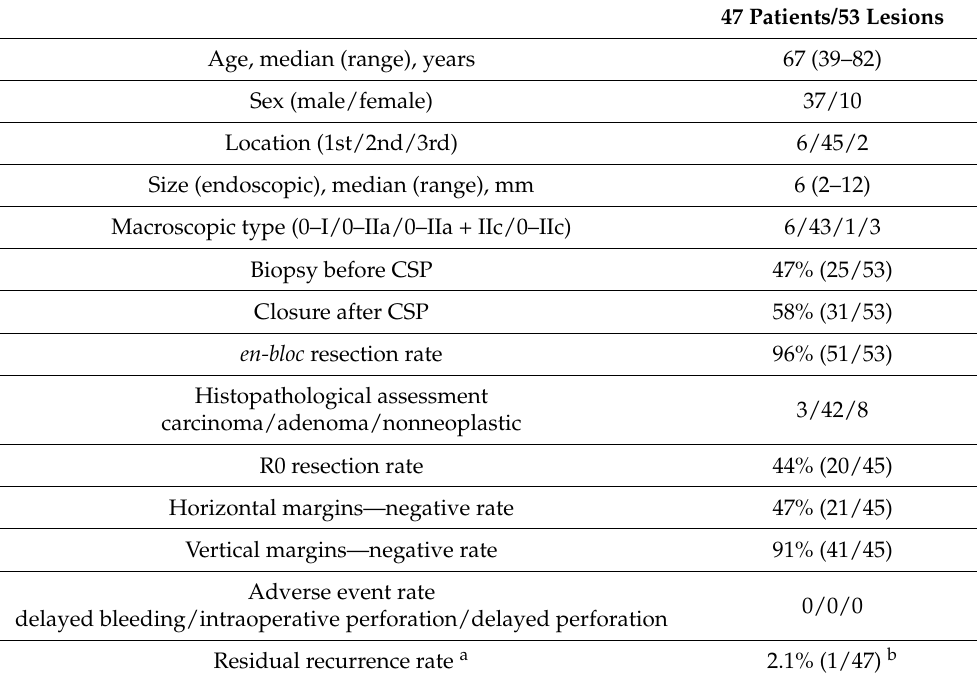
Table 1. Treatment outcomes of cold snare polypectomy (CSP) at our